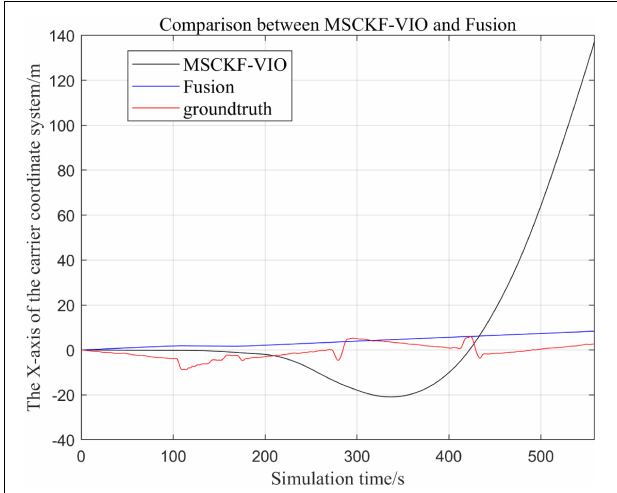
FIGURE 4 | Comparison of the overall trajectory of the fusion algorithm with the MSCKF_VIO algorithm in the x -axis.